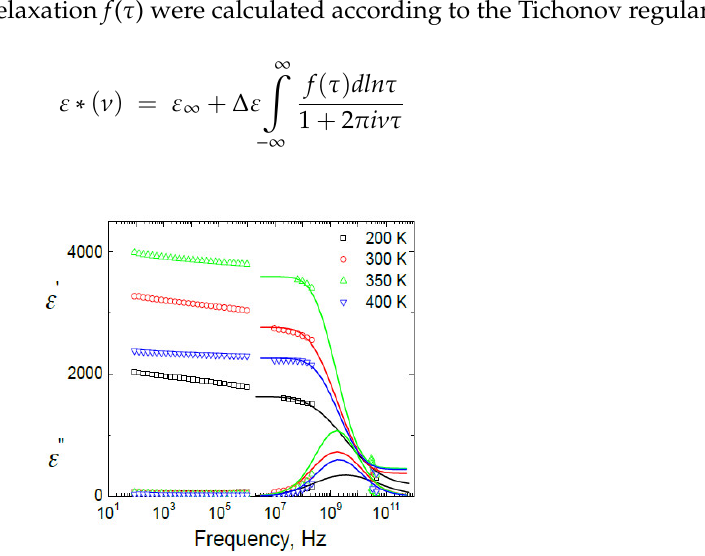
Figure 5. Distributions of relaxation times for BCT ceramics.